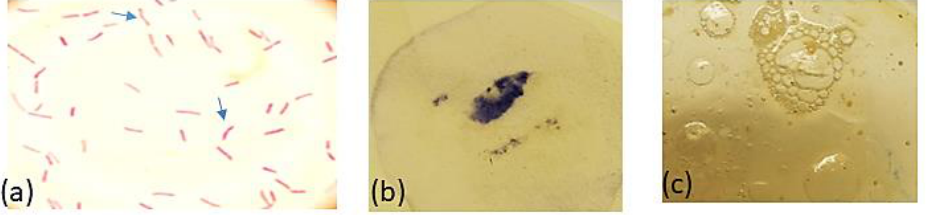
Figure 3. ( a ) Gram-stained H. pylori cells showing slightly curved, red-colored rods (arrows) and some are straight rods with blunt ends; ( b ) positive oxidase test; and ( c ) positive catalase test showing effervescence after subjection to hydrogen peroxide solution. Table 2. Morphological and biochemical characteristics detected among H. pylori isolates.